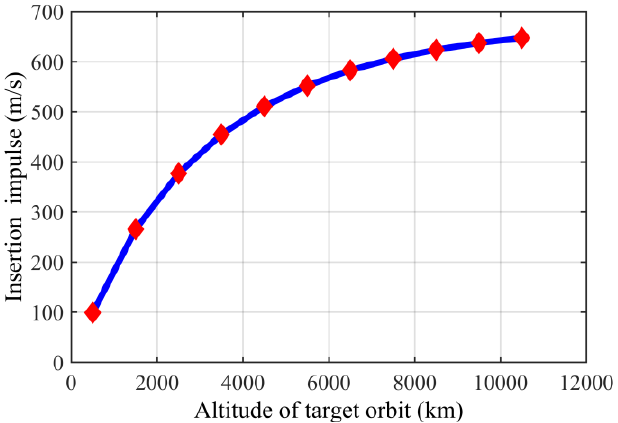
Figure 14. Insertion velocity pulse vs. altitude of target orbit profiles.